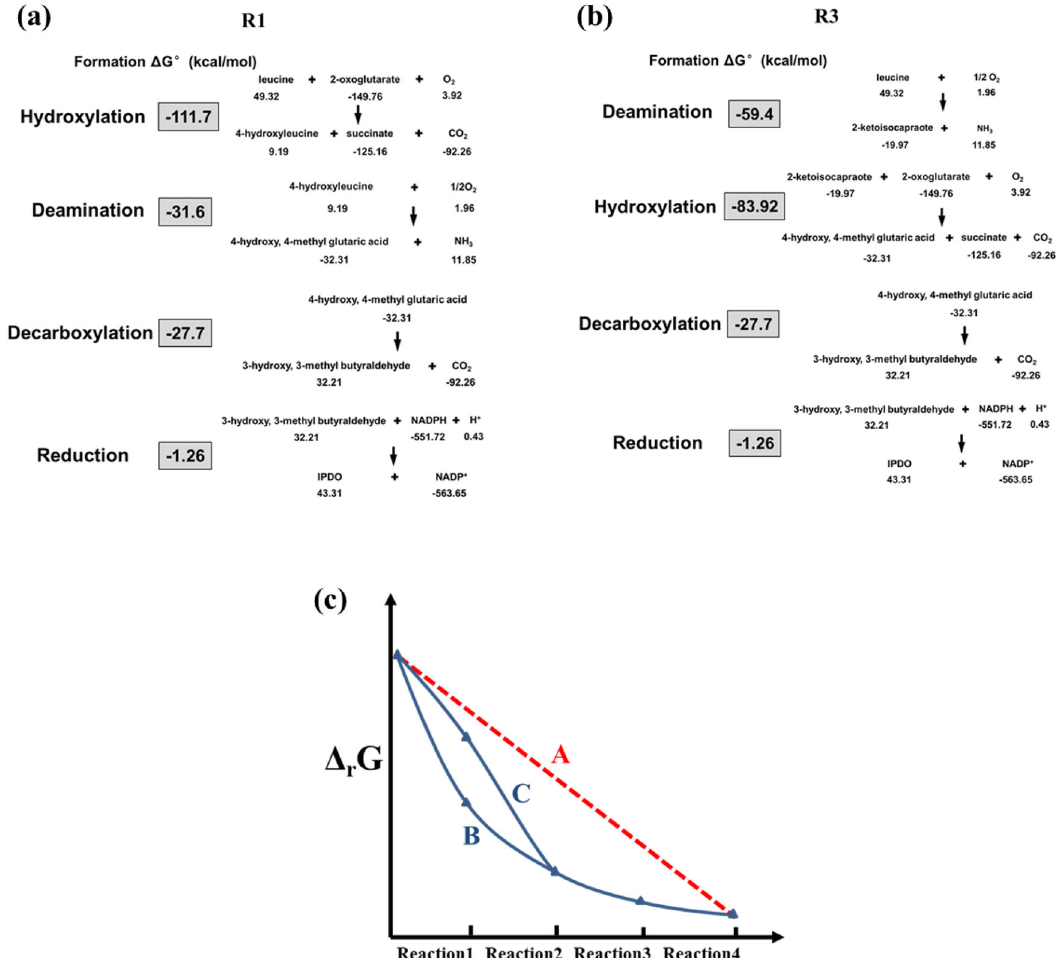
Fig. 4 Thermodynamic pro fi les of reaction orders R1 and R3 for the biosynthesis of IPDO from leucine. a , b Thermodynamic calculations of the reaction orders R1 and R3 of a four-step reaction cascade. The standard Gibbs free energy of formation of every non-natural product was estimated by using the group contribution method. c Schematic comparison of reaction driving forces ( Δ r G) of three synthetic pathways that starts from the same substrate and end with the same product. We assumed that curve A (red dashed line) stands for a pathway with an ideal thermodynamic pro fi le: the driving forces of all four reactions are identical. Curve B re fl ects the thermodynamic pro fi le of Route 1 ( a ) that begins with a strong exergonic reaction with high energy driving force while curve C re fl ects the thermodynamic pro fi le of Route 3 ( b ) that begins with a less thermodynamic favorable